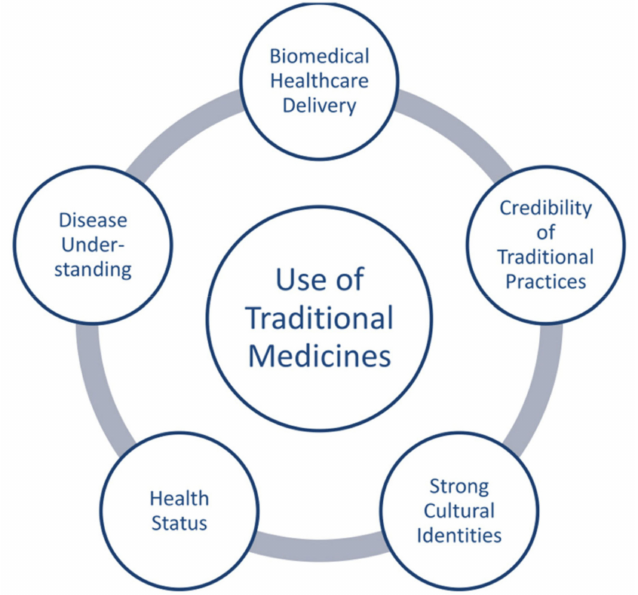
Figure 1. “Determinants for the use of Traditional Medicines”. Reprinted under the terms of the Creative Commons Attribution License from, Stanifer, J.W.; Patel, U.D.; Karia, F.; et al. The determinants of traditional medicine use in Northern Tanzania: a mixed-methods study. PLoS ONE 2015 , 10 (4), e0122638.